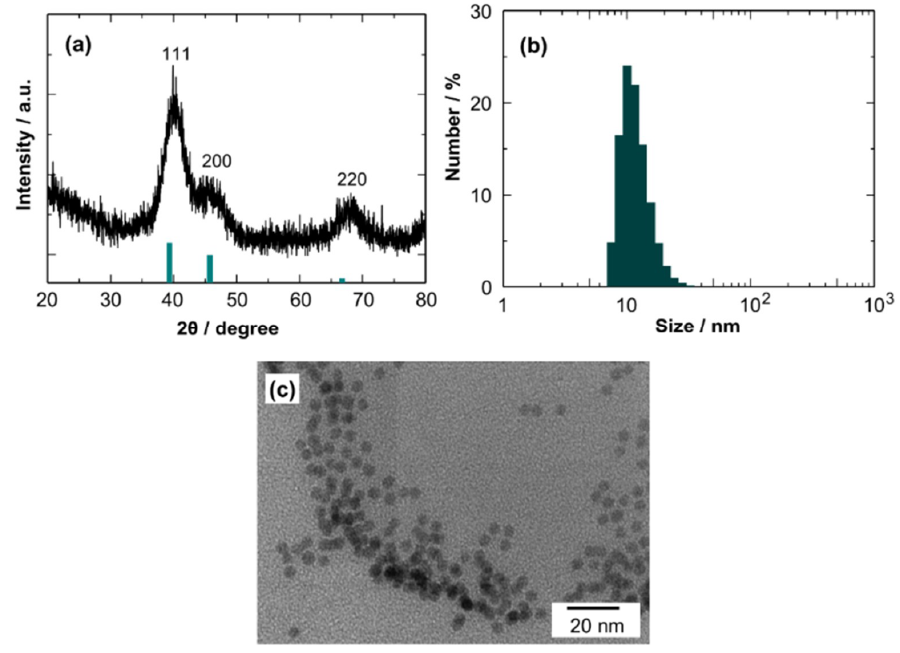
Figure 5. ( a ) XRD pattern, ( b ) particle size distribution, and ( c ) TEM image of Pd NCs.